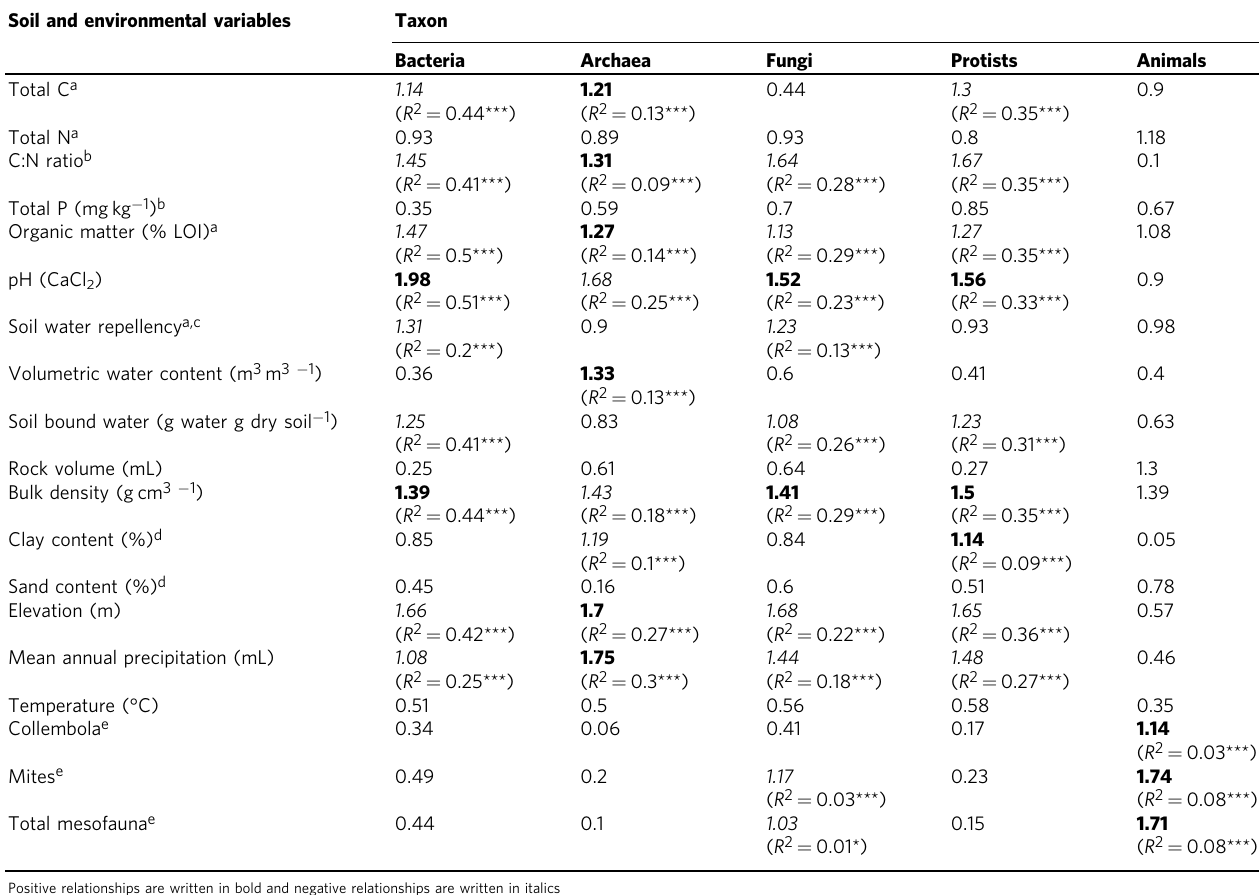
Table 1 Results of partial least squares regressions for soil biota against soil properties for richness Soil and environmental